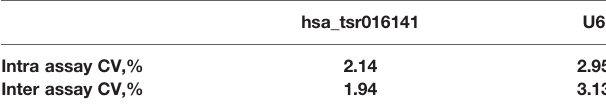
TABLE 1 | The Intra-Assay CV and the Inter- Assay CV of hsa_tsr016141.